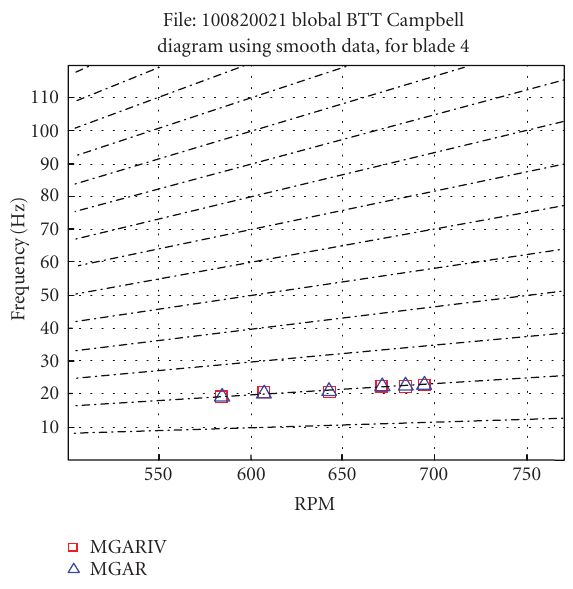
Figure 8: Single resonance case: Campbell diagram constructed from BTT multidegree of freedom analysis.